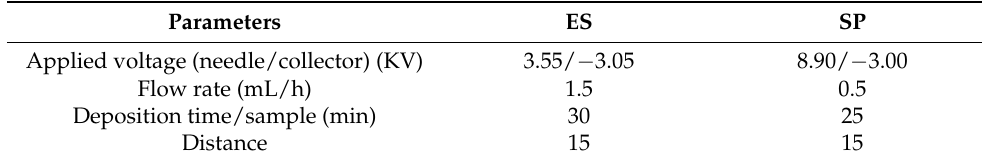
Table 2. Configuration of the electrospinning and electrospraying parameters. Parameters ES SP Applied voltage (needle/collector)